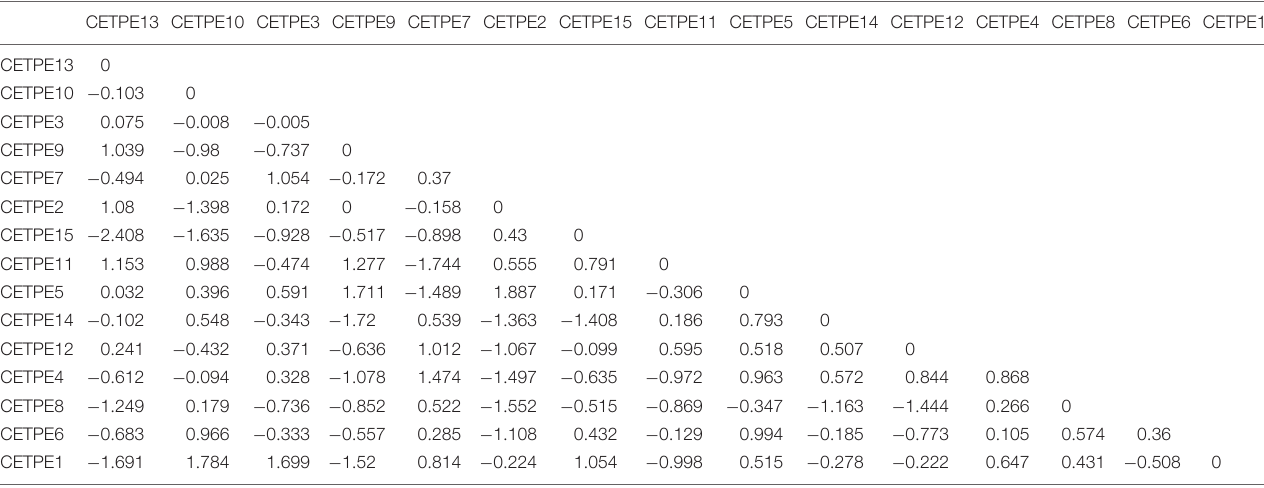
TABLE 11 | Standardized residual covariances (group number 1 – default model).